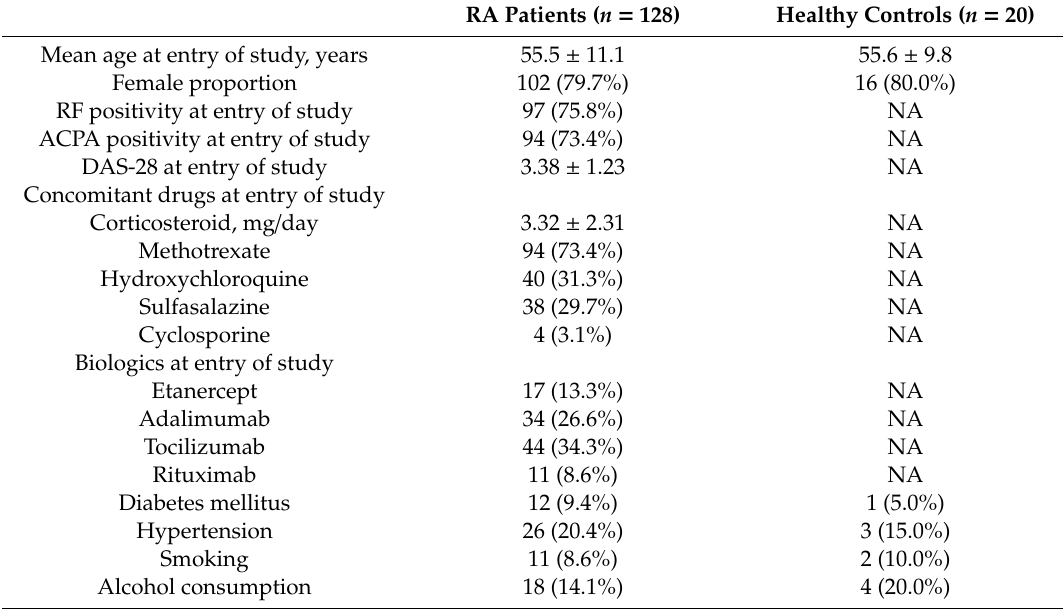
Table 1. Demographic data, laboratory findings and concomitant used medications in patients with rheumatoid arthritis (RA)